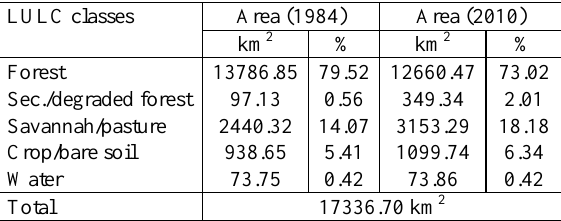
Table 2. LULC dynamics between 1984 and